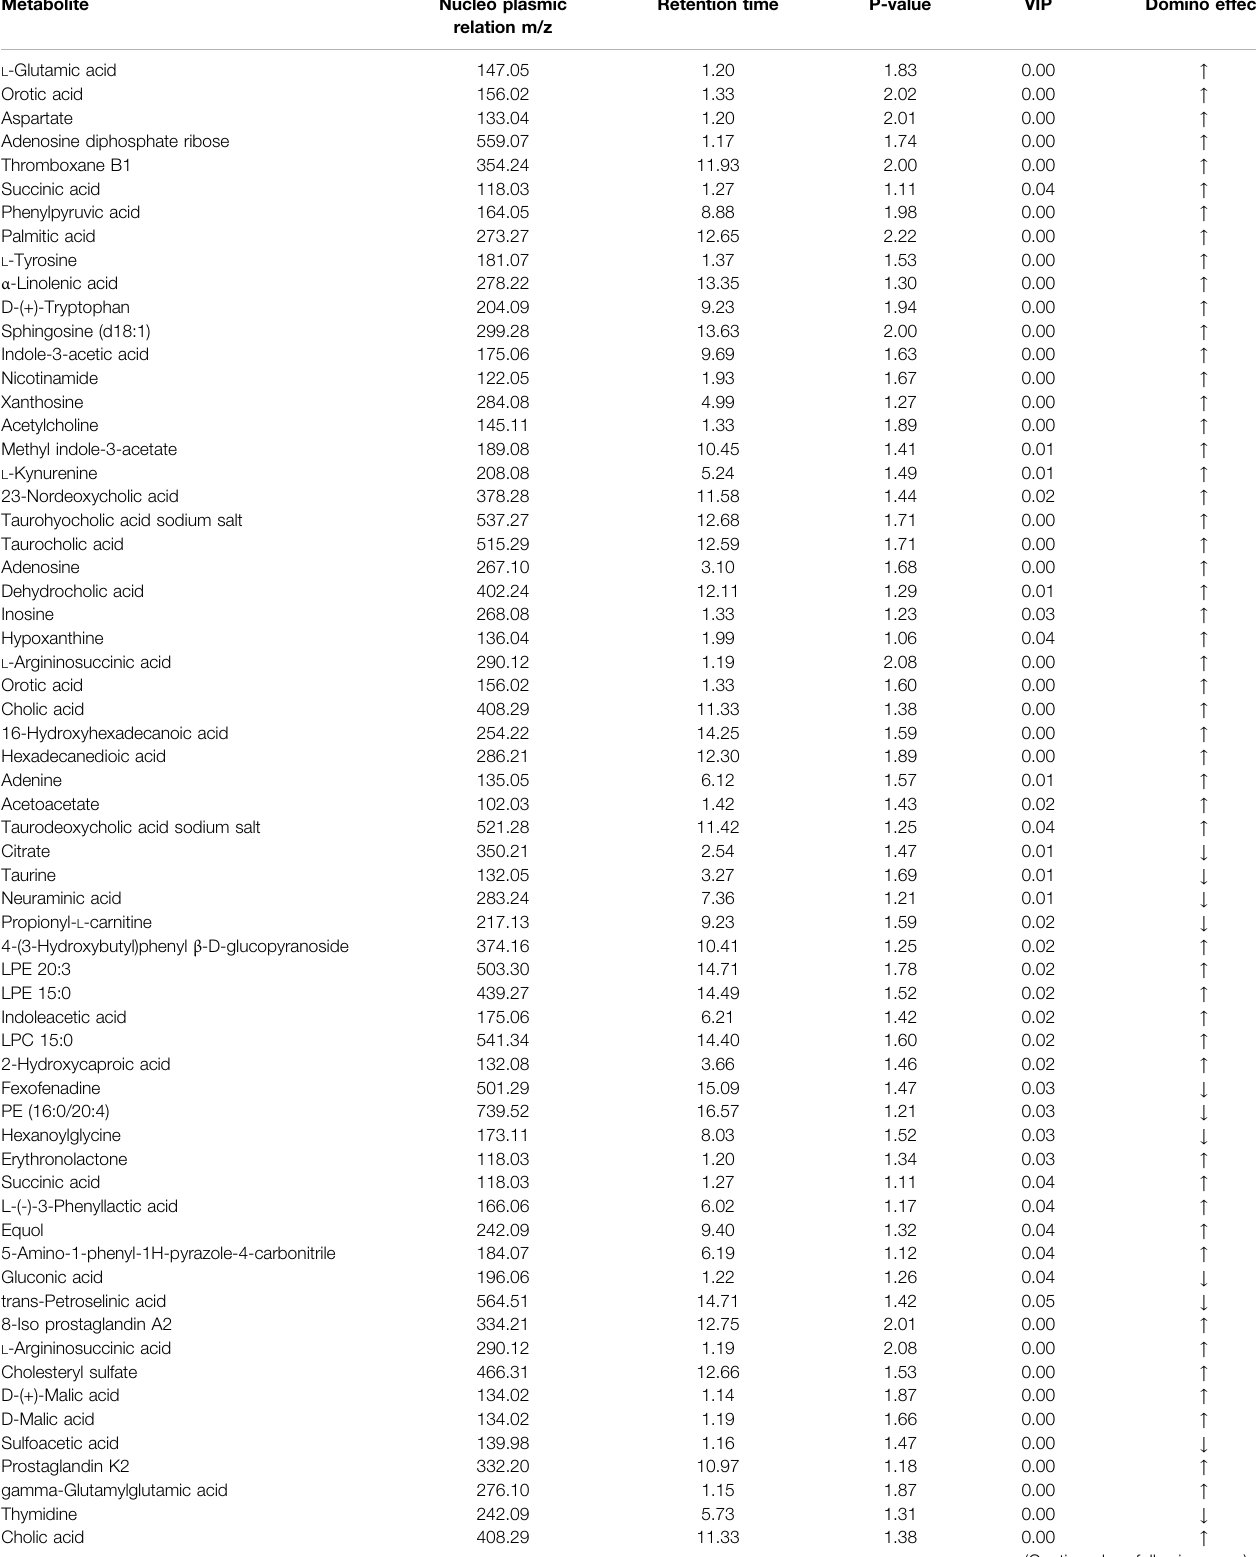
TABLE 3 | Expression of differential metabolites between the UUO model group and the SKI